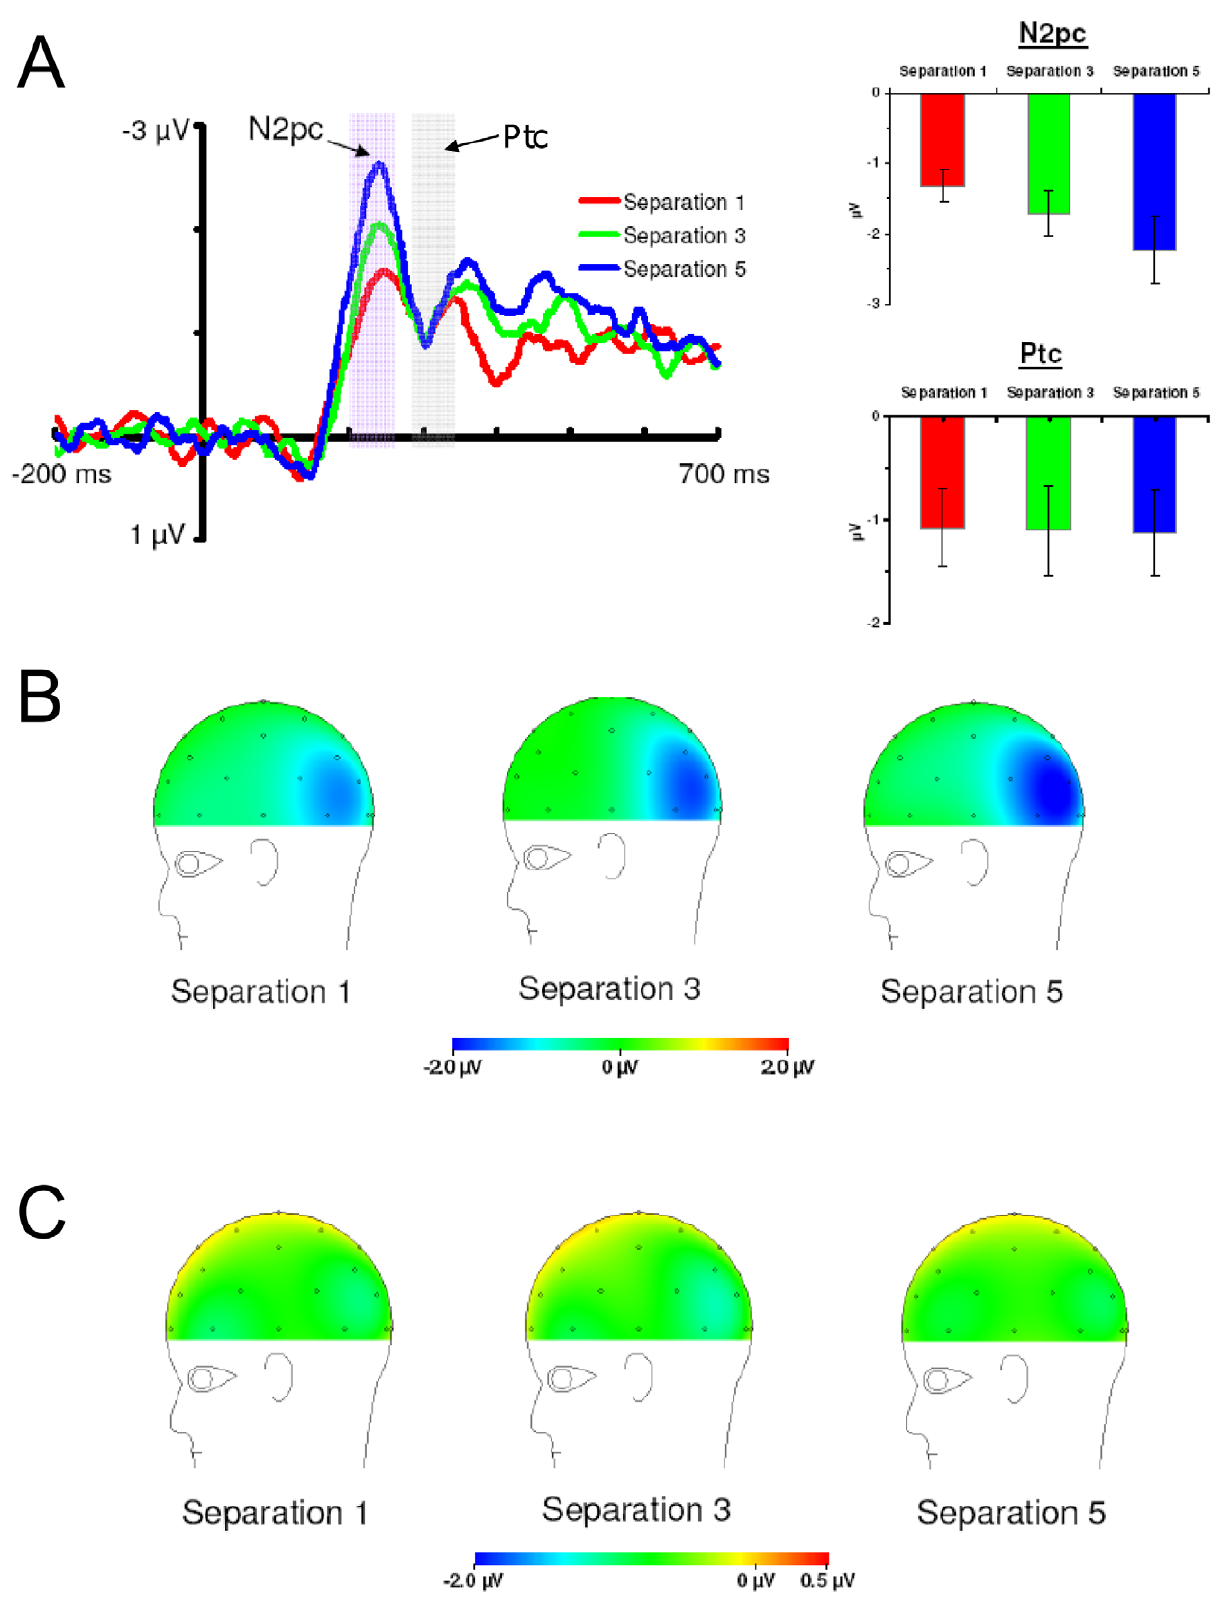
Figure 4. Difference waveforms and scalp distributions from Experiment 1. (a) Left: Ipsilateral/contralateral difference waveforms at electrodes PO3/4 from Experiment 1. These were calculated by subtracting the ipsilateral waveforms from the contralateral waveforms plotted in Figure 3. These difference waveforms allow N2pc and Ptc amplitude to be compared across levels of target-target separation. Right: N2pc and Ptc